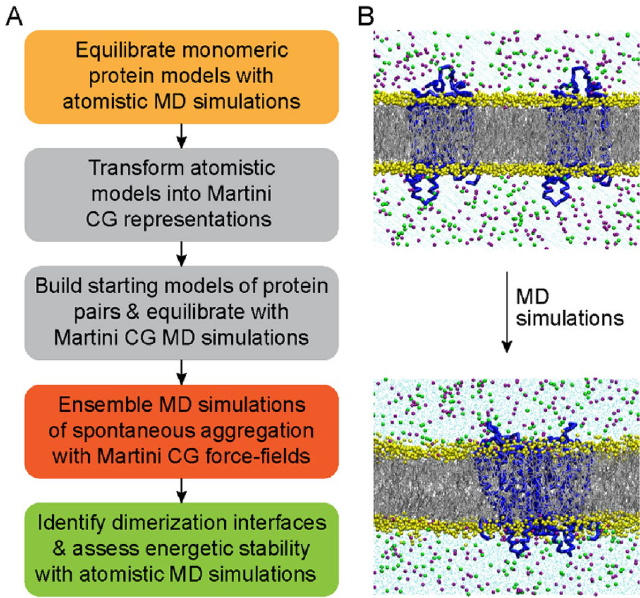
Figure 4. Set-up for computational analysis of opsin dimerization in a lipid membrane. (A) Multiscale computational protocol to investigate dimerization of WT and F220C opsins in a lipid membrane. (B) Starting (top) and final (bottom) snapshots of the WT opsin system after CG MD simulations. Initially well-separated monomers (center-of-mass distance of 50 Å) spontaneously aggregate on the 120 μs timescale of the CG simulations. In the snapshots, opsins are shown in blue cartoon, lipid phosphate beads in yellow spheres, and lipid tails in grey lines. Also depicted are salt ions in solution (green and purple spheres) and water beads (cyan